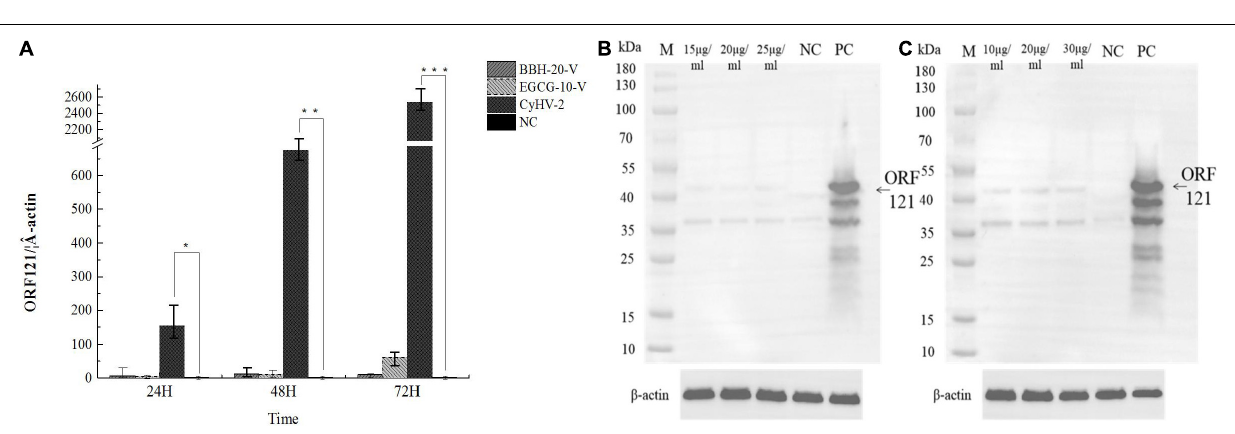
FIGURE 8 | Inhibition of viral gene transcription and viral protein synthesis by either BBH or EGCG. RyuF-2 cells were treated with 15, 20, and 25 µ g/ml BBH or 10, 20, and 30 µ g/ml EGCG and infected with CyHV-2 at a MOI = 1. At 24, 48, and 72 h p.i., infected cells treated with 20 µ g/ml BBH or 10 µ g/ml EGCG were harvested for viral gene expression analysis with the ORF121 as target by real-time RT-PCR analysis (A) . At 72 h p.i., infected cells treated with 15, 20, and 25 µ g/ml BBH (B) or 10, 20, and 30 µ g/ml EGCG (C) were harvested for protein expression analysis by western blot, which targeted ORF121 with a home-made anti-ORF121 polyclonal antibody. Real-time RT-PCR results were obtained from three independent experiments, and data were presented as means SD. * P < 0.05; ** P < 0.01. MOCK-infected cells served as the negative control and CyhV-2-infected cells without BBH or EGCG treatment served as the positive control. Housekeeping protein β -actin served as the internal control in the western blot